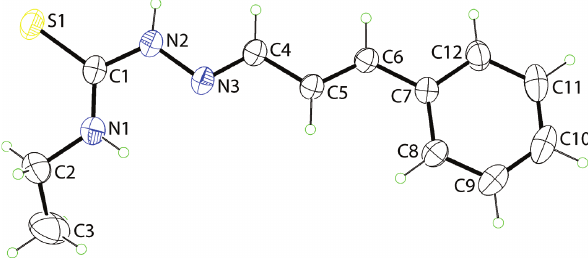
Table 1: Data collection and handling.